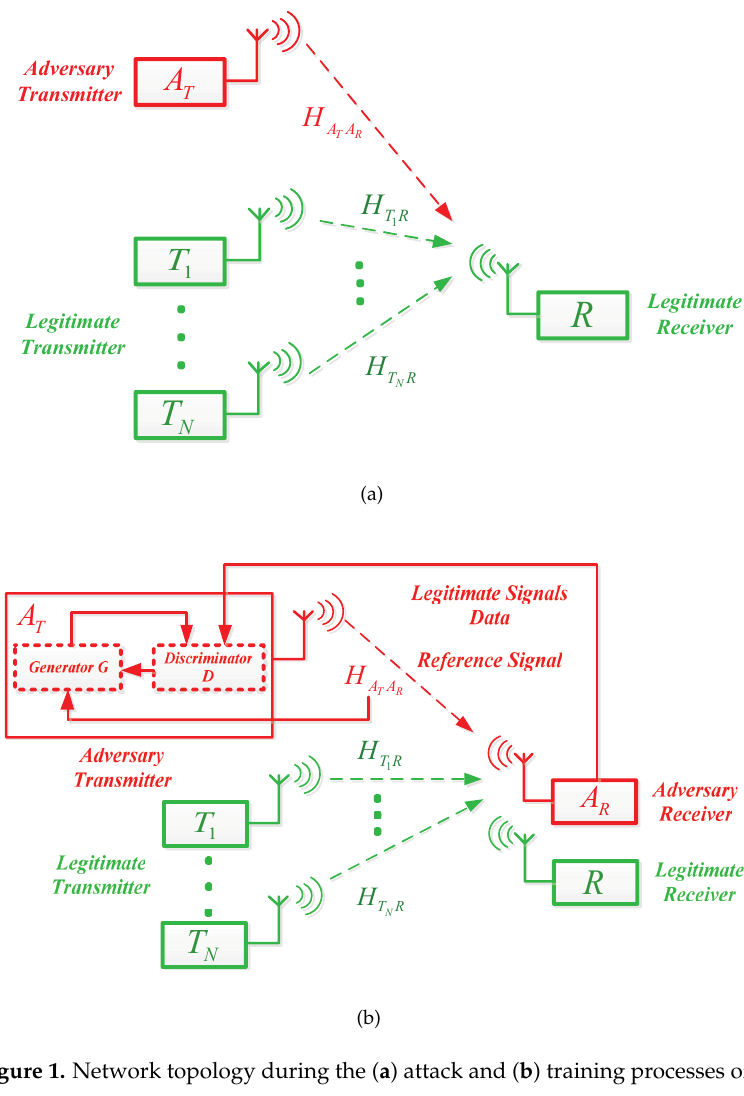
Figure 1. Network topology during the ( a ) attack and ( b ) training processes of spoofing